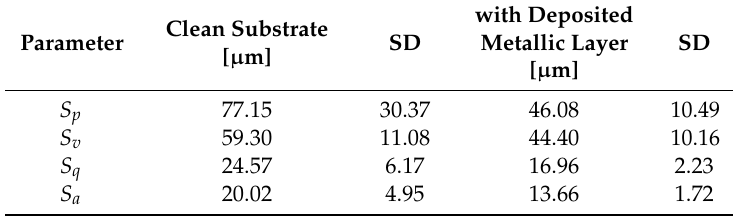
Table 5. Cordura area roughness parameters measured from OCT images.